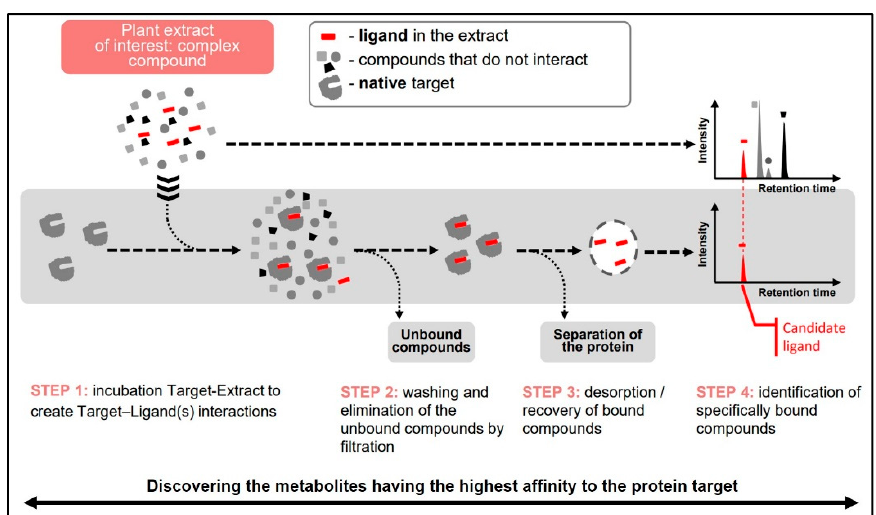
Figure 8. Di ff erent steps of the target binding strategy to identify ligand with an a ffi nity to a Figure 8. Different steps of the target binding strategy to identify ligand with an affinity to a protein protein target.